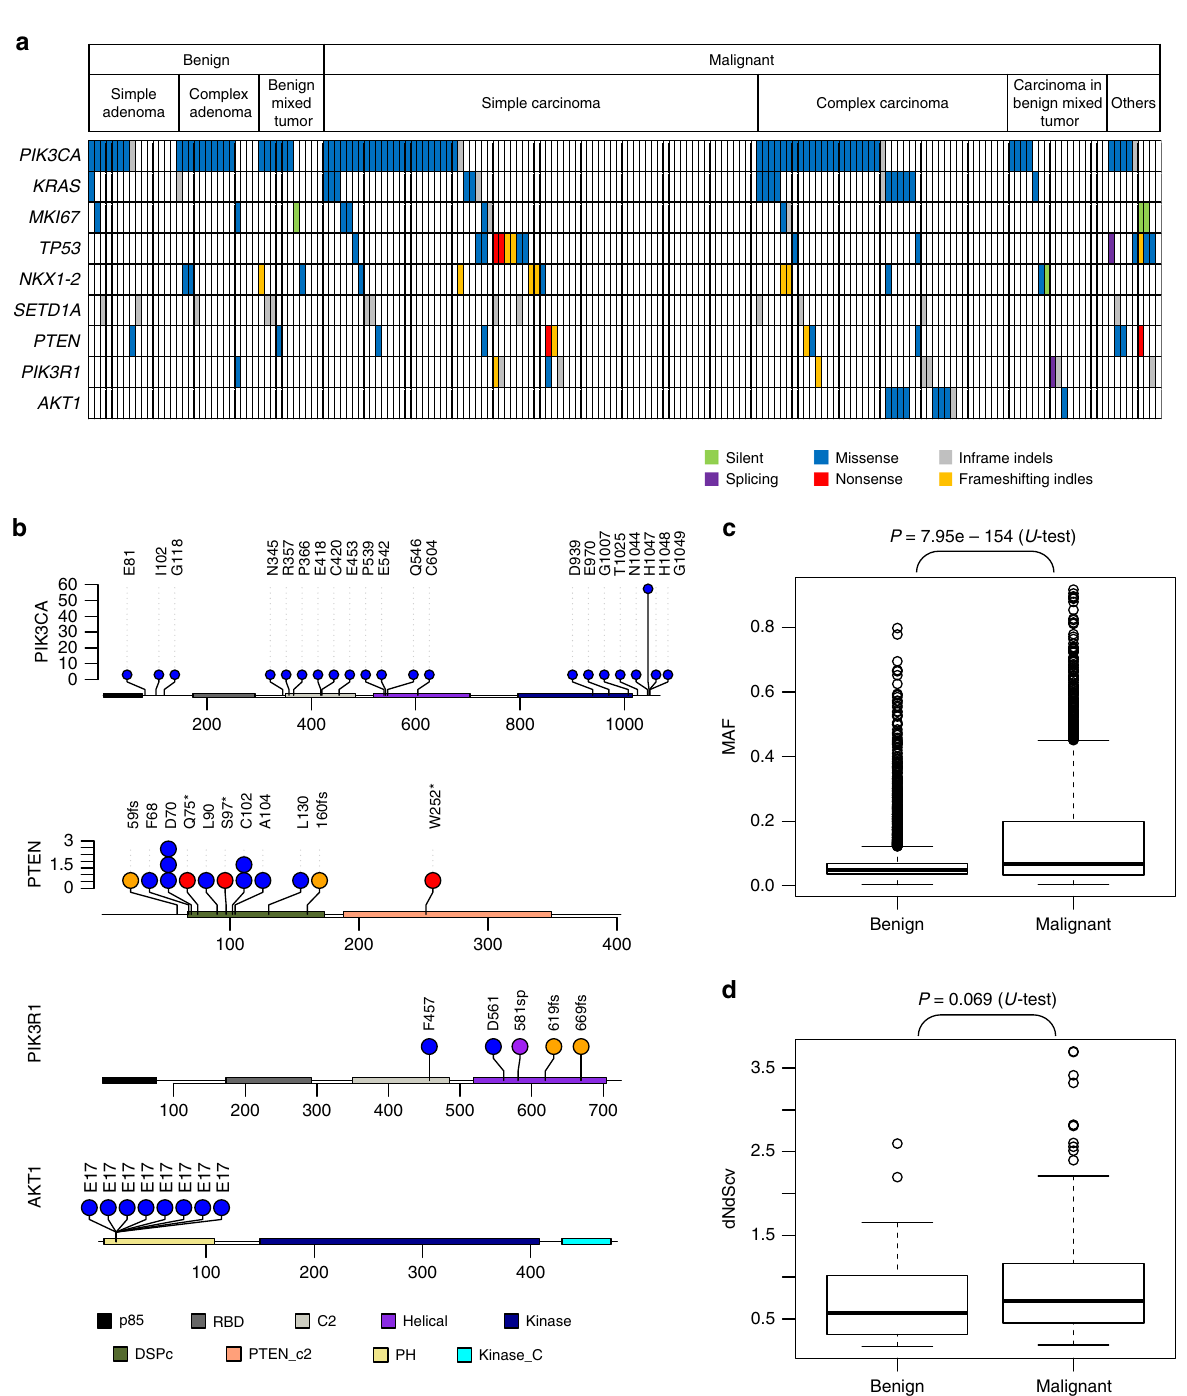
Fig. 1 Landscape of somatic mutations in CMT. a The mutational landscape of 183 CMTs (40 benign and 143 malignant CMTs) are shown for nine recurrently mutated genes. For benign and malignant CMTs, major histology types are shown at the top. Six mutation classes with respect to functional changes in the encoded amino acids are shown according to the color legend. b Non-silent mutations in four PI3K-Akt pathway genes are shown in lollipop plots. c Mutant allele frequencies of 3968 and 497 mutations in benign and malignant CMTs are compared. d dNdScv values are compared between 38 benign and 136 malignant CMTs. The signi fi cance was estimated by two-sided U tests. For all boxplots in this manuscript, the median and 1st/3rd quartiles of the data were plotted as the center line and the lower/upper boundaries. Whiskers represents the minimum and maximum of the data after removing outliers, which were de fi ned as values smaller than 1st quartile – 1.5× IQR (interquartile range) or larger than 3rd quartile + 1.5×